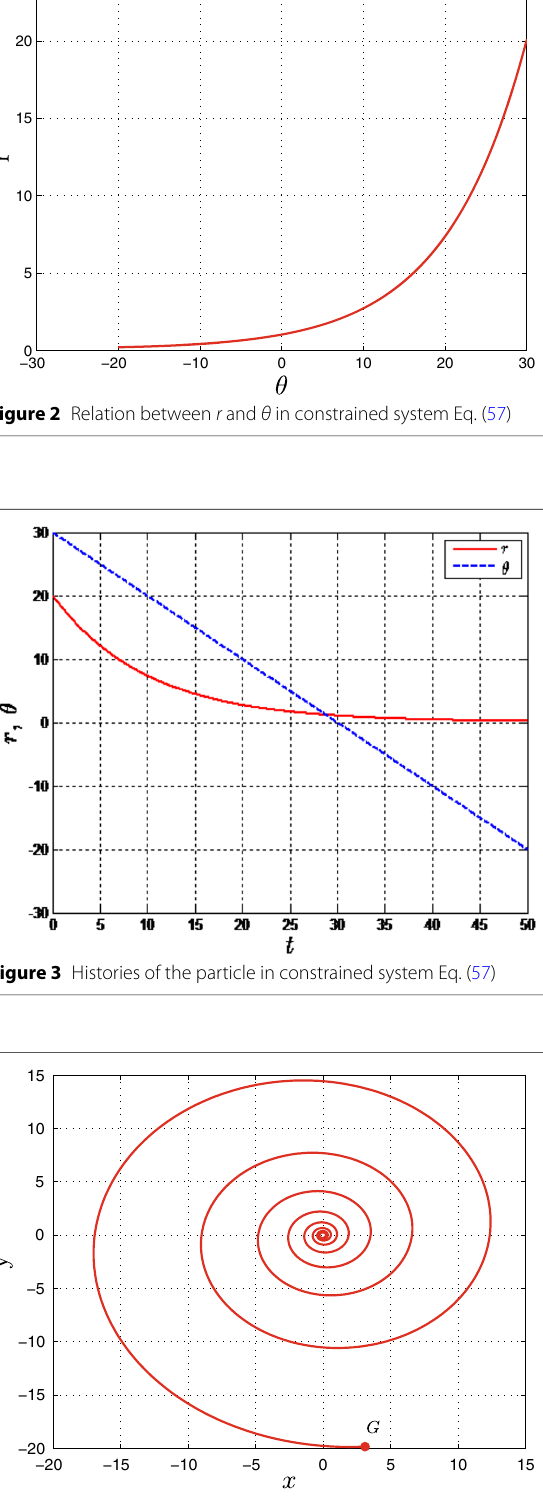
Figure 4 Trajectory of the particle in constrained system Eq. (57)